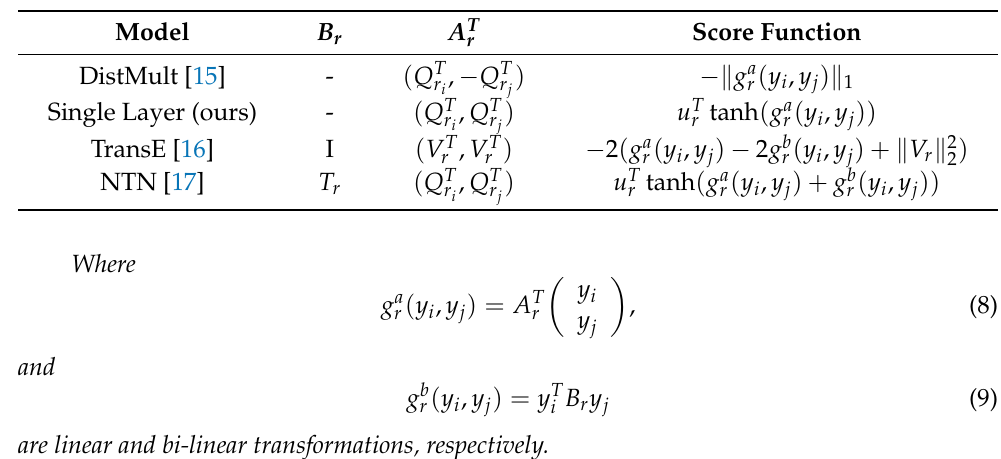
Table 1. Different score